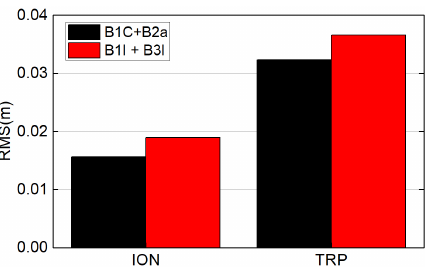
Figure 5. ( a ) The residuals of pseudo-range and phase observations for B1C+B2a combination of BDS-3 in WH04-HG02. ( b ) The residuals of pseudo-range and phase observations for B1I+B3I com- bination of BDS-3 in WH04-HG02.